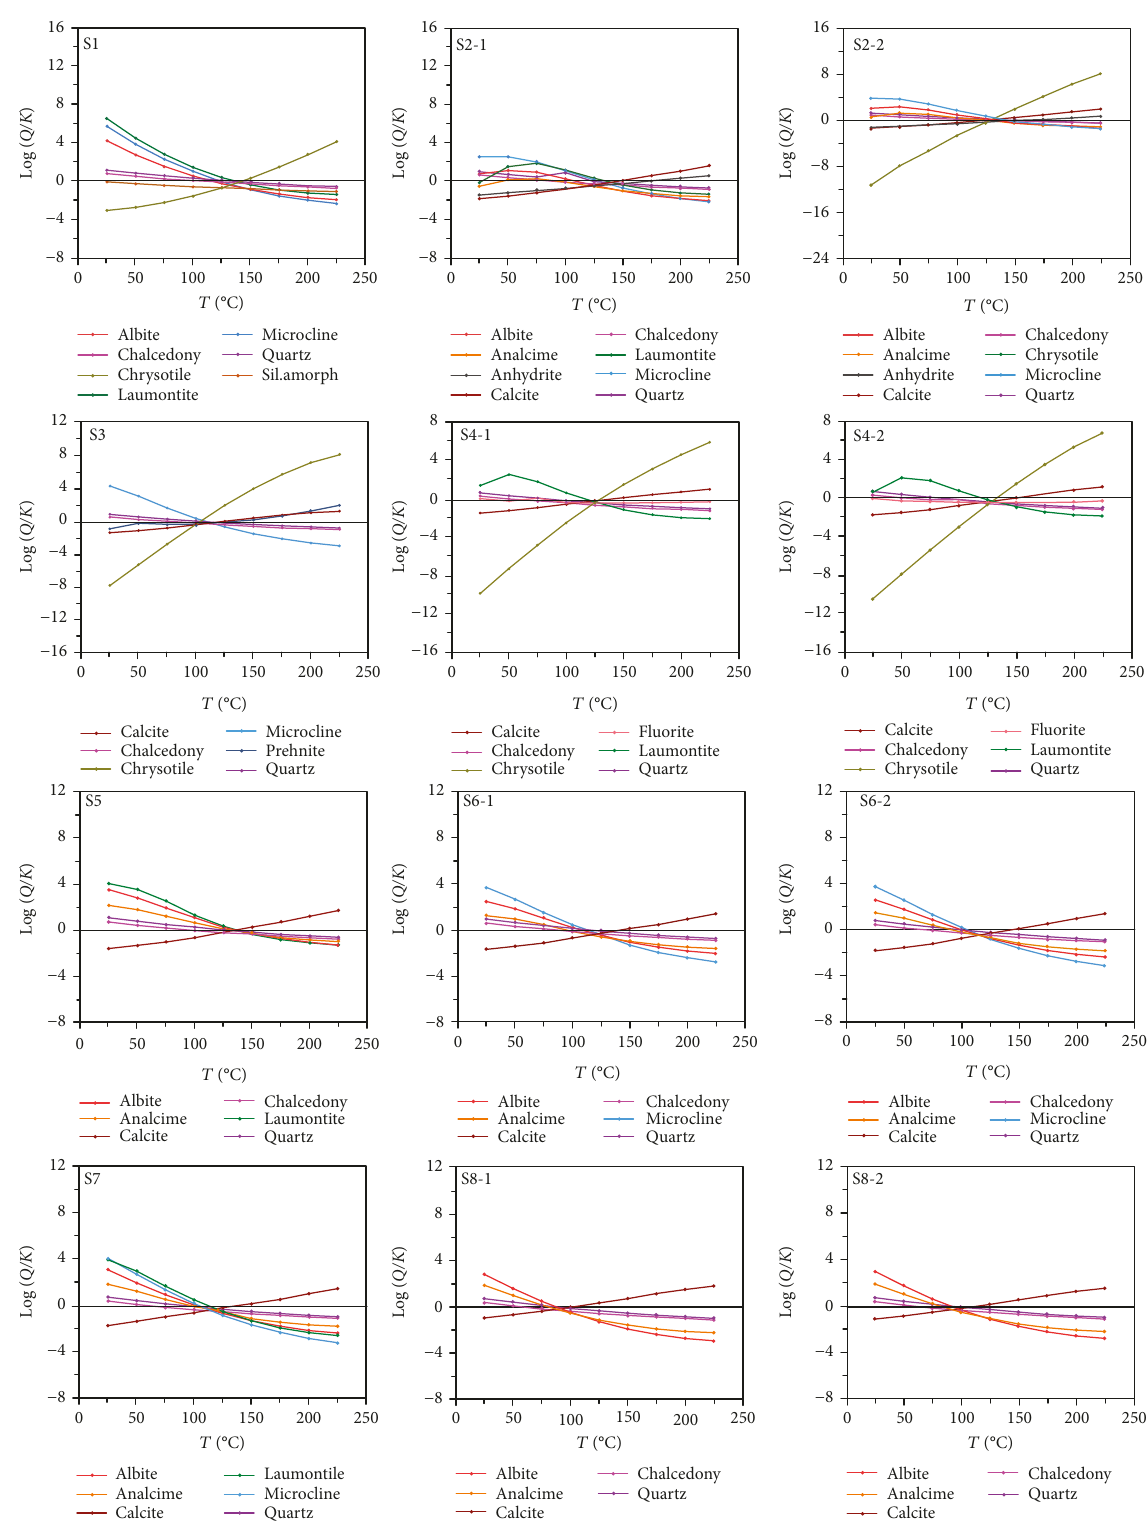
Figure 12: Fixed-Al diagram showing the hot spring water samples in the Simao